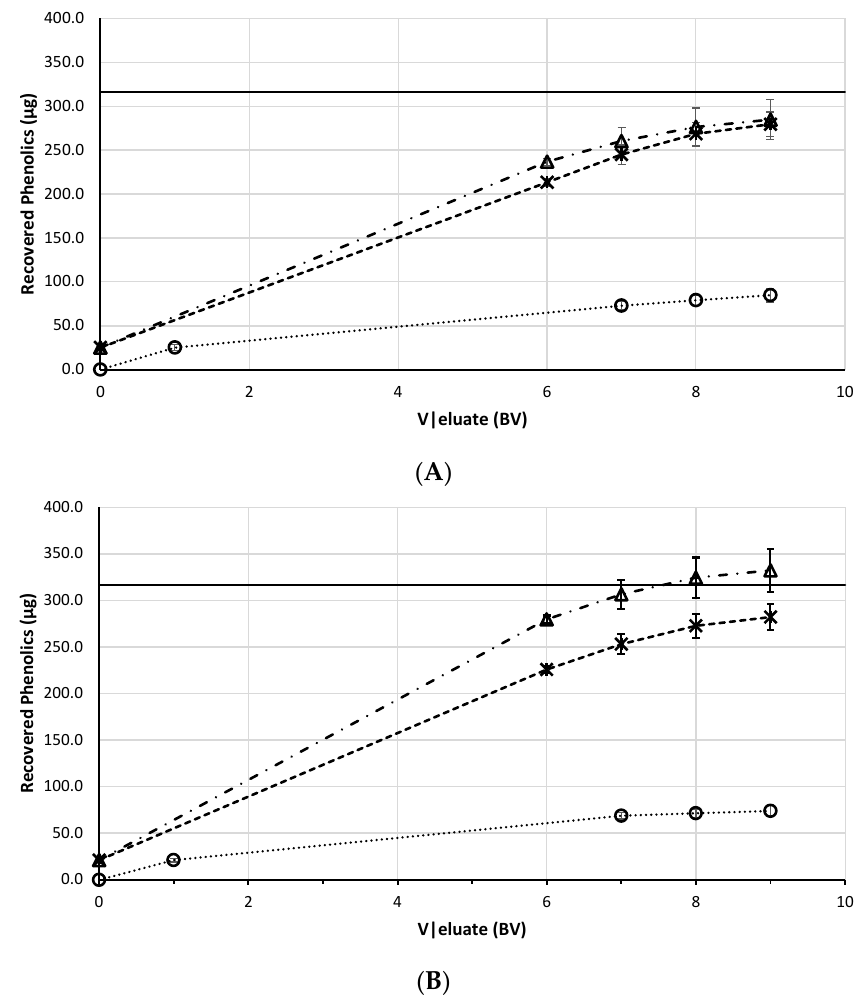
Figure 2. Amount of recovered phenolic compounds ( μ g) using different desorption solutions: water ( ○ ), 50/50 ethanol ‐ water mixture (x), and ethanol ( Δ ), in resins XAD ‐ 2 ( A ) and HP ‐ 20 ( B ). Solid line marks the maximum amount of phenolic compounds, considering the eluted feed (6 BV of spent broth).